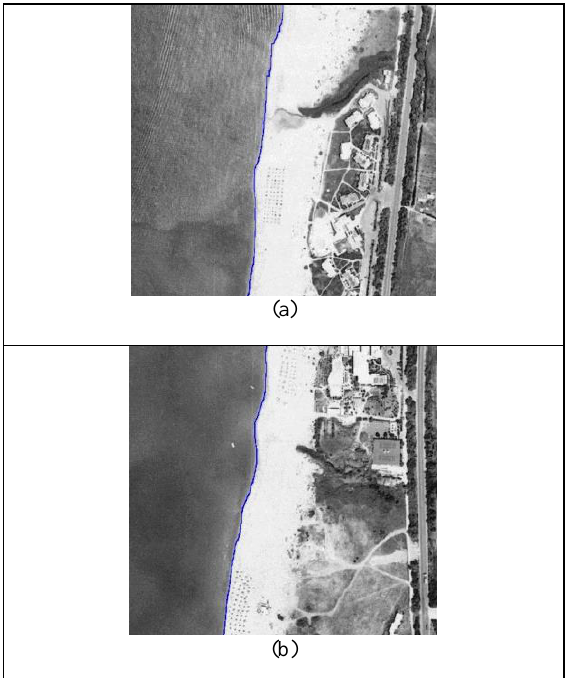
Figure 4. Results of post-processing: (a) image after concatenation of binary blocks, (b) image after removing objects out of the area of interest and filling blank spaces at land area.